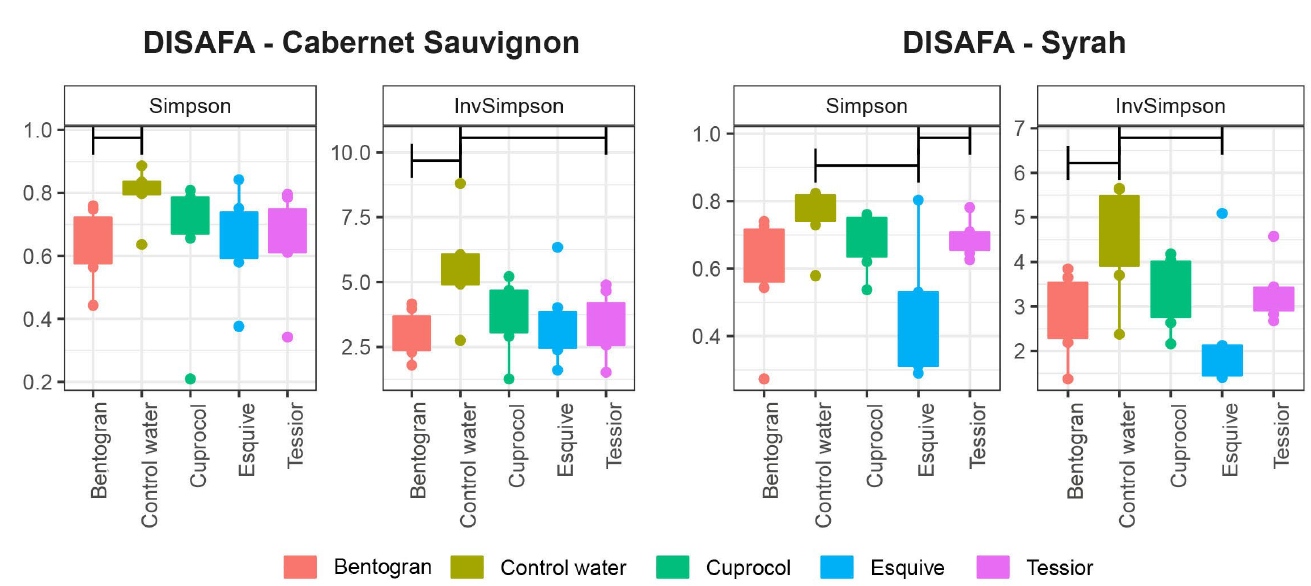
Figure 3. Box plots of alpha diversity indices (Simpson and InvSimpson) showing the richness of the fungal communities in canes treated with different pruning wound protection products (Bentogran, control water, Cuprocol, Esquive and Tessior) in Cabernet Sauvignon and Syrah from the Almotivo and DISAFA vineyards. The horizontal brackets marked with an asterisk (*) indicate statistical differences, while brackets without asterisks indicate trends (0.15 < p < 0.05).